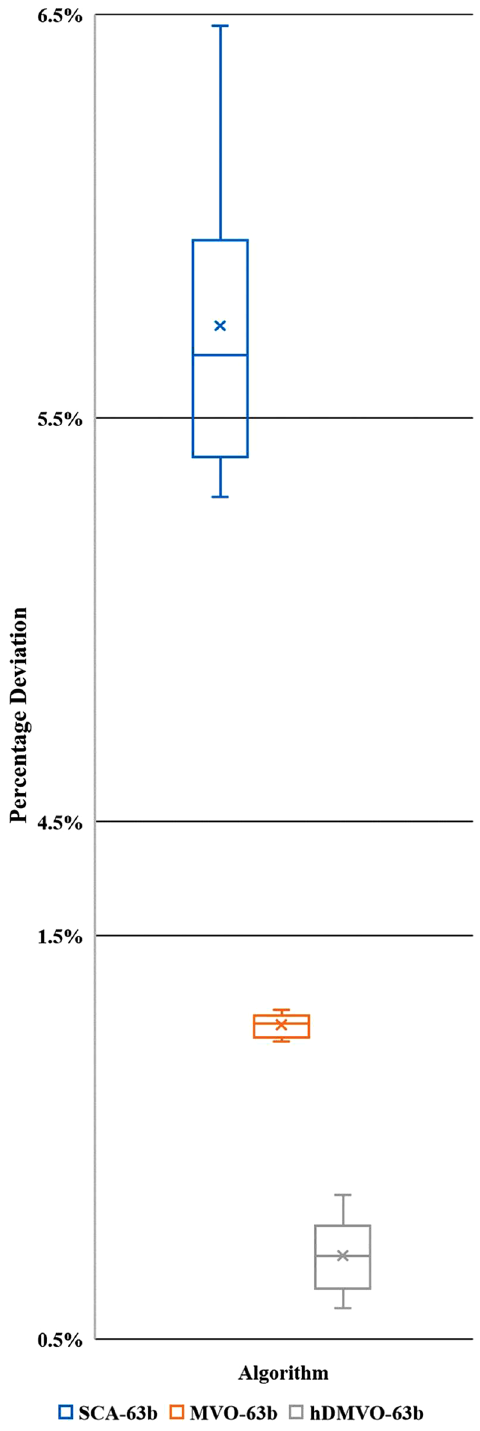
Figure 12. Percentage deviations of hDMVO, MVO and SCA in problem